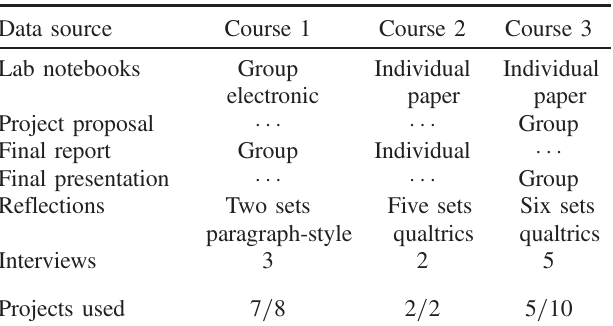
TABLE II. Description of data sources used for each course. Dots indicate the source was not used for a specific course. Projects used shows the number of projects analyzed from that course compared with the total number of